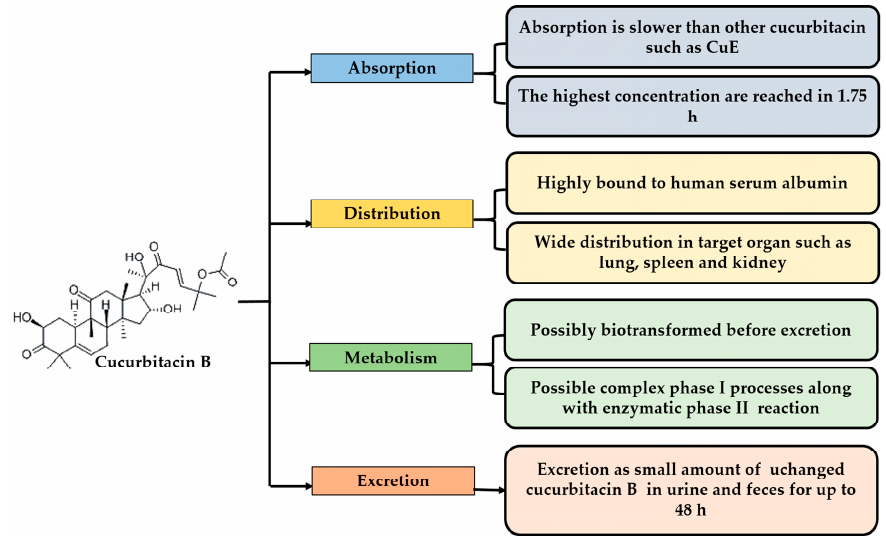
Figure 2. The pharmacokinetic properties of cucurbitacin B.